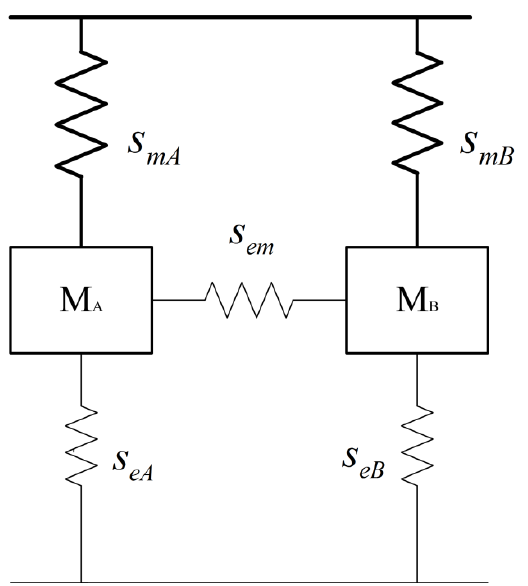
Figure 4. Mechanical equivalent of double-generator